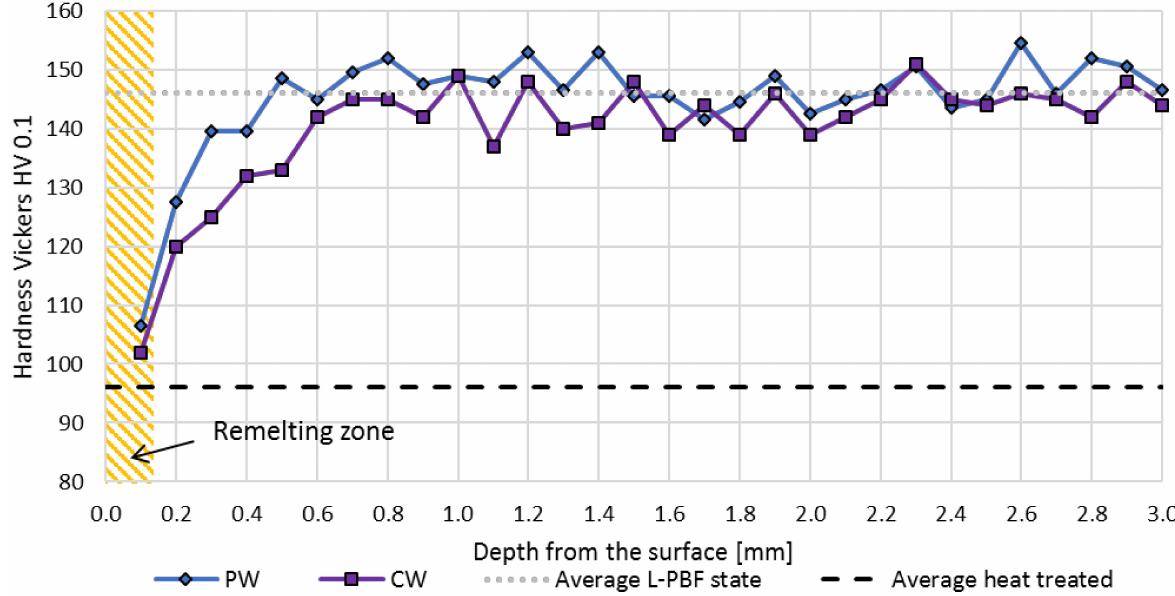
Figure 14. Micro hardness according to Vickers HV 0.1 over the material thickness after laser polishing, measured at the cross section at half of the polishing